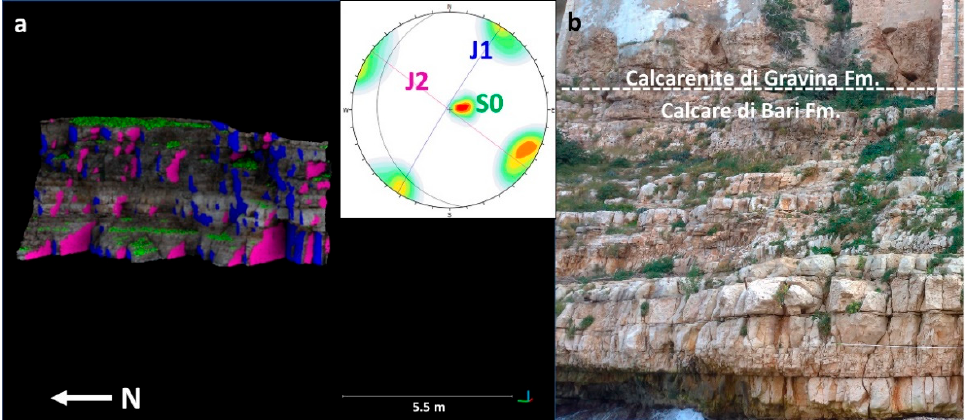
Figure 3. Geostructural setting of the study site; ( a ) sub-vertical joint sets (J1, J2) and bedding surfaces (S0) detected in the Calcare di Bari Fm. by means of field surveys and UAV point cloud inspection; ( b ) details of the fracture network in the Calcare di Bari Fm. and of the massive structure of the Calcarenite di Gravina Fm. Table 2. Main geostructural and geomechanical parameters of the Calcare di Bari Fm.